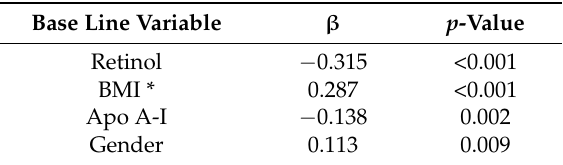
Table 3. Results of linear regression model to identify independent determinants of hs-CRP plasma